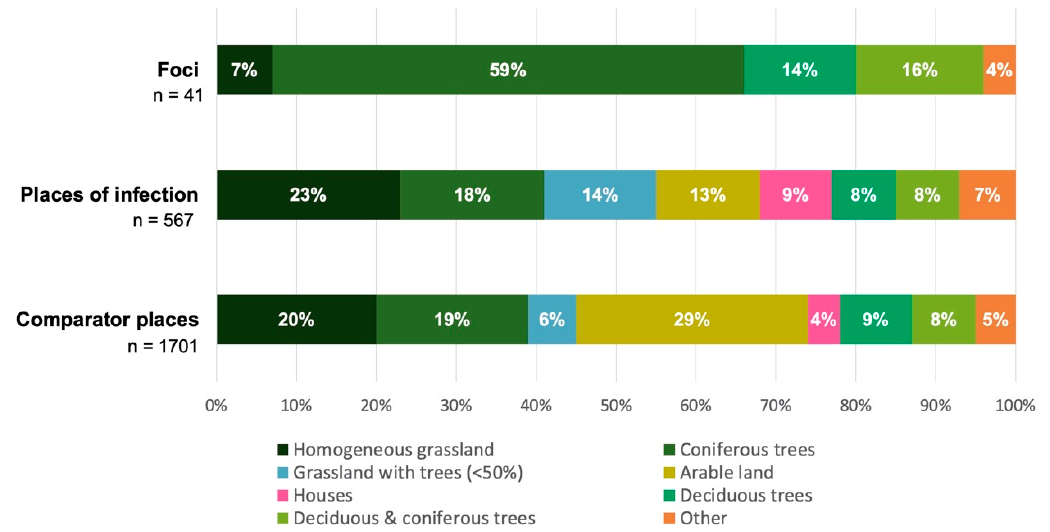
Figure 3. Proportion of land cover types for self-reported places of TBE infection with assumed TBE virus presence, natural TBE foci with confirmed TBE virus presence, and random comparator places as pseudo absences.